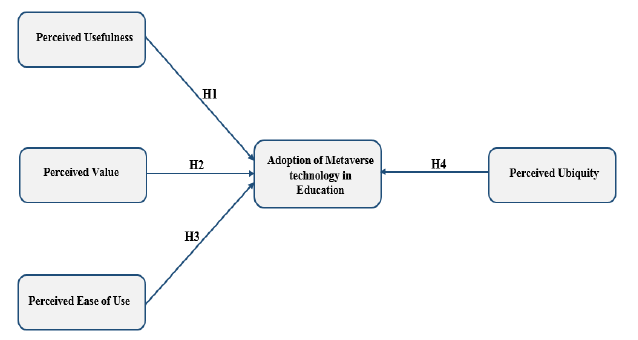
Fig. 1. Model of the